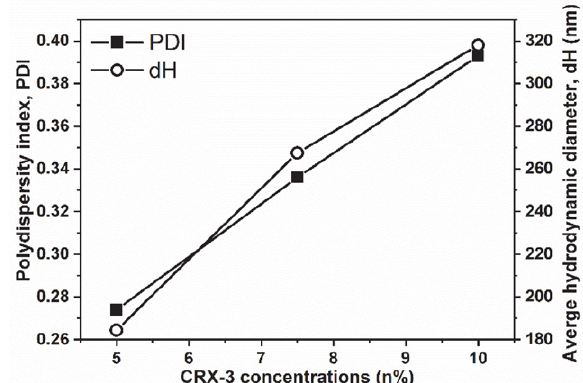
Figure 4. Polydispersity index and average hydrodynamic diameter values of the synthesized PEGMA particles as a function of the amount of CRX-3 used during